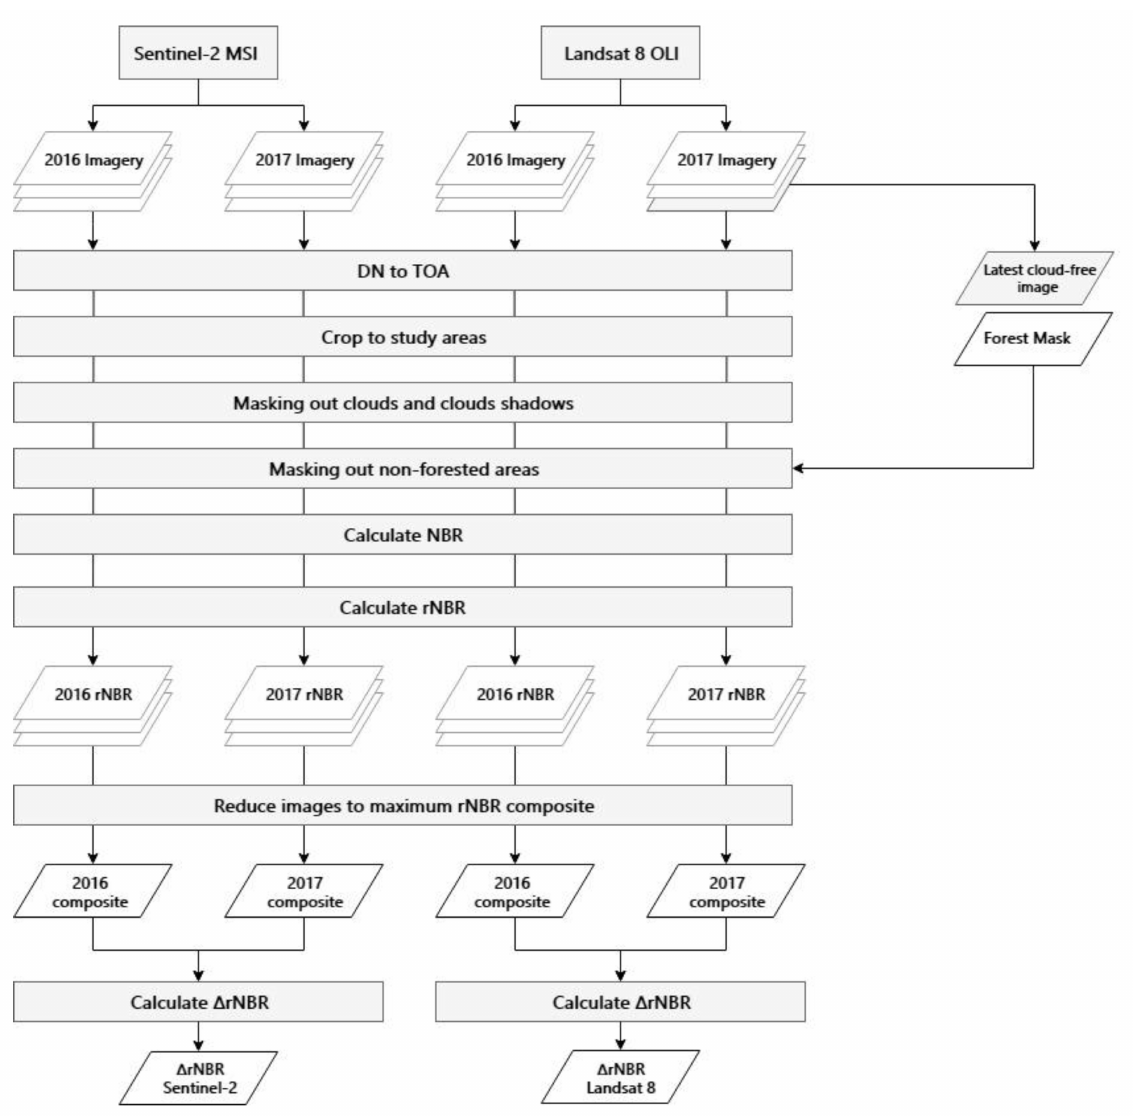
Figure 2. Flowchart of the steps used to generate the delta self-referenced normalized burn ratio ( ∆ rNBR) image. MSI: MultiSpectral instrument; OLI: Operational land imager; DN: digital numbers; TOA: Top of atmosphere reflectance; NBR: normalized burn ratio; rNBR: self-referenced normalized burn